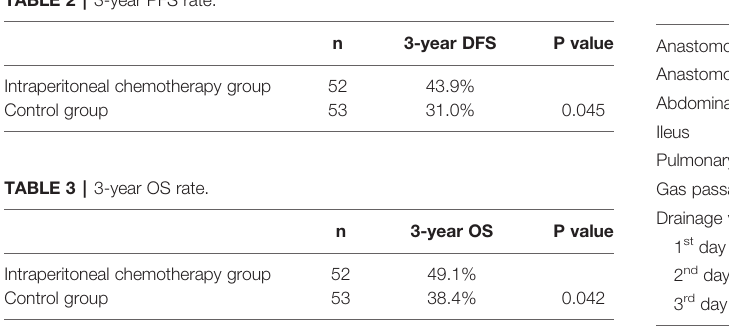
TABLE 2 | 3-year PFS rate.